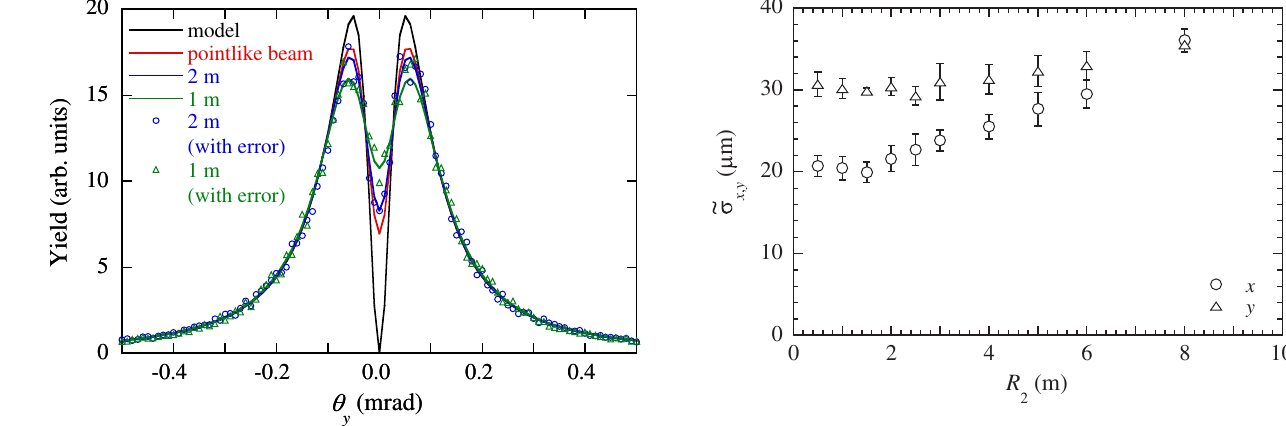
FIG. 6. Vertical angular distribution of radiation. Model DTR angular distribution, radiation distribution for a pointlike electron beam, and distributions for the extended electron beam and distances R 1 ¼ 2 m and R 2 ¼ 1 m. Electron energy 10 GeV; silicon crystal; (022) reflection order; observation angle Θ ¼ 32 . 2 D